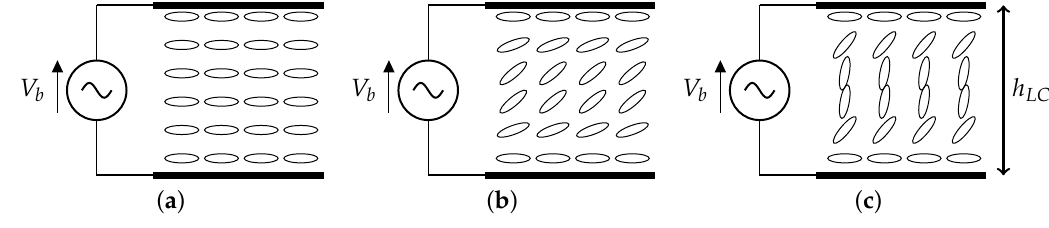
Figure 1. Polarization of a nematic liquid crystal cell: ( a ) V b < V th , ( b ) V max > V b > V th , ( c ) V b > V max